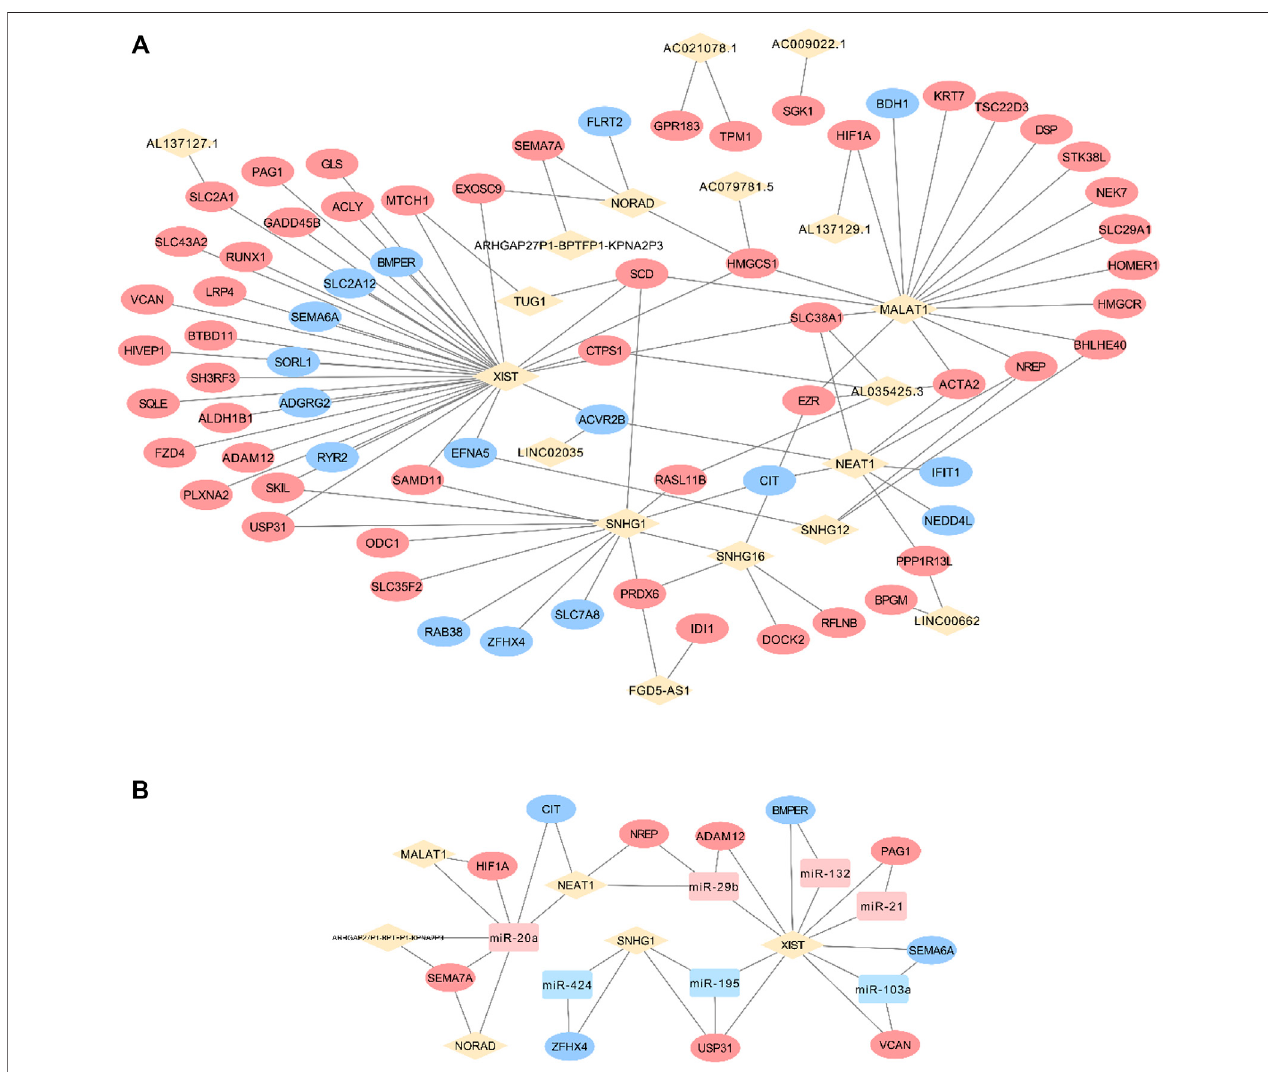
FIGURE 5 | FS mRNA and FR lncRNA interaction. The direct interaction relationships were visualized (A) and the Ce-loop RNA network was also extracted (B) . Rhombuses, squares,and circles stand forlncRNAs,miRNAs,and mRNAs,respectively. Upregulated RNAs areshown inpink, while downregulated onesareshown in blue. Gray lines represent regulatory